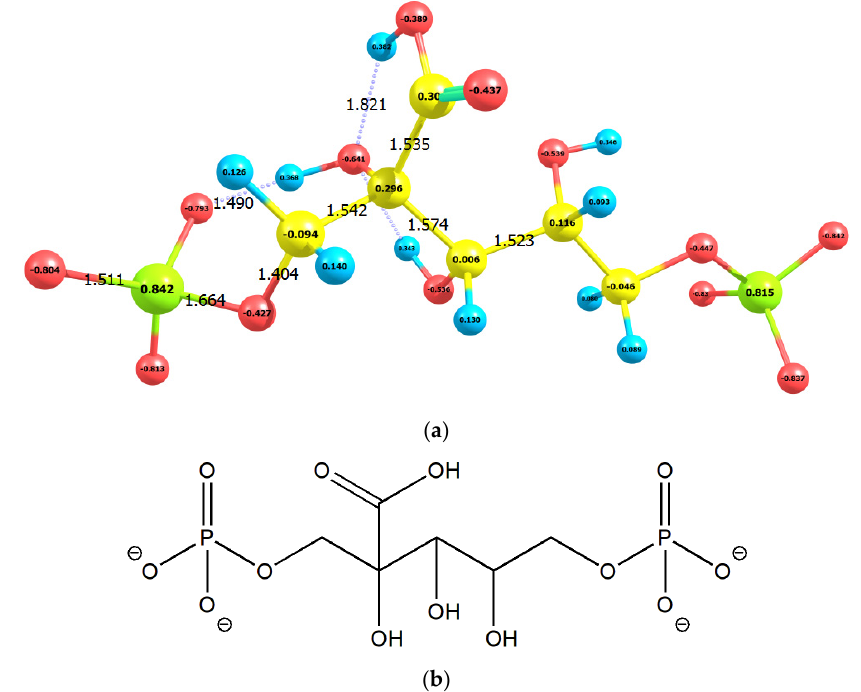
Figure A9. ( a ) The calculated geometric and electronic structure of 2-carboxy- D -arabinitol 1,5- bisphosphate (CABP); Q = − 4, M = 1, E 0 = − 51,603.53 eV, G 0 = − 51,599.18 eV. Hessian has negative frequencies: − 82.12, − 18.16 (cm − 1 ). ( b ) The scheme of 2-carboxy-2,3,4-trihydroxypentane-1,5-diyl